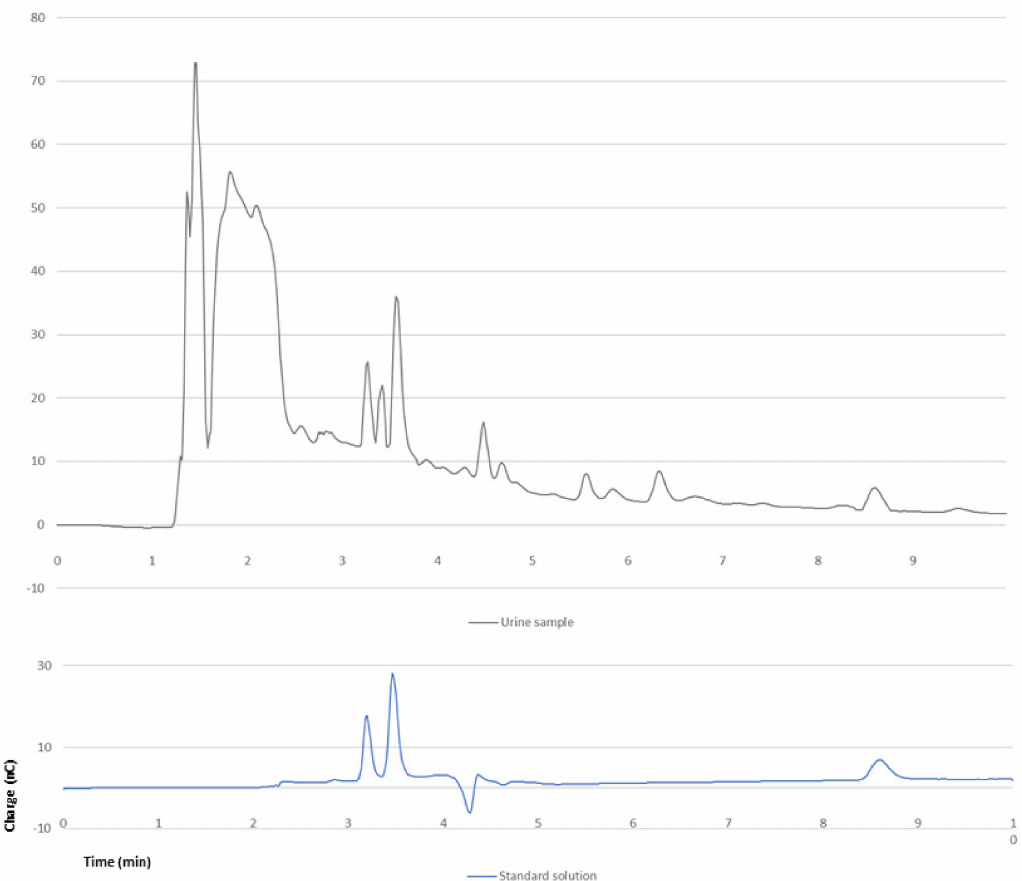
Figure 5. Chromatographic separations of a mixed standard solution of β -agonists, each at a concentration of 100 µ g.L − 1 (blue) and a calf urine sample spiked at 10 µ g.L − 1 (grey) and purified by SPE (10 fold concentration factor). Experimental conditions as in Figure 4.